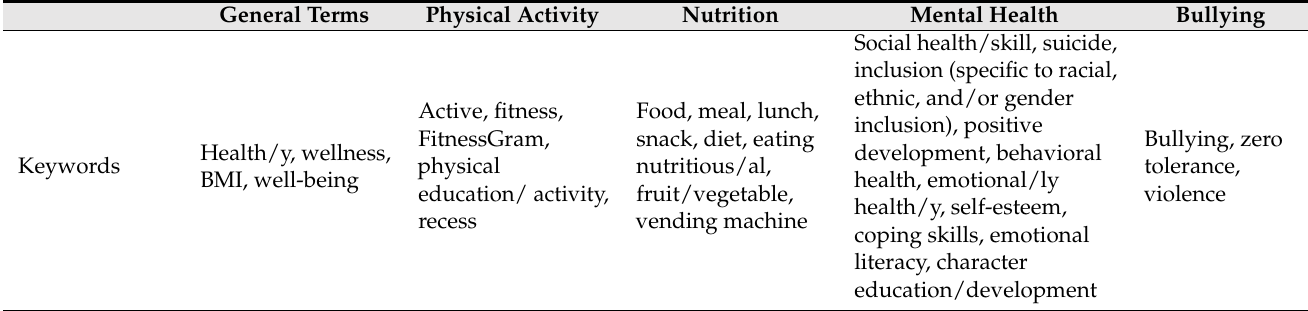
Table 1. Keywords Used to Search Campus Improvement Plans in Texas (SPAN 2015–2016